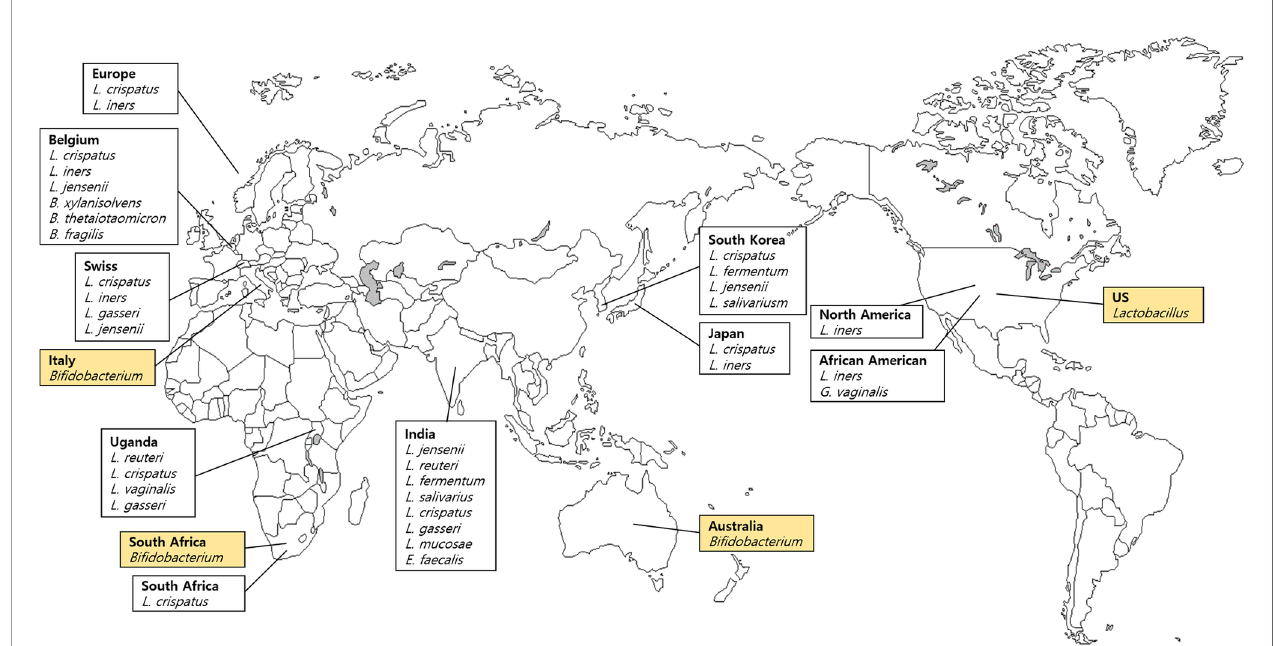
FIGURE 3 | Dominant bacteria in vaginal fl uid samples based on the Forensic Microbiome Database (www.fmd.jcvi.org) data and non-FMD studies. The yellow- colored box is from the FMD data, and only bacteria which account for over 10% are shown. Four countries from the FMD and 10 countries from previous studies were included, and the microbiome pro fi ling was generated using 16S rRNA gene